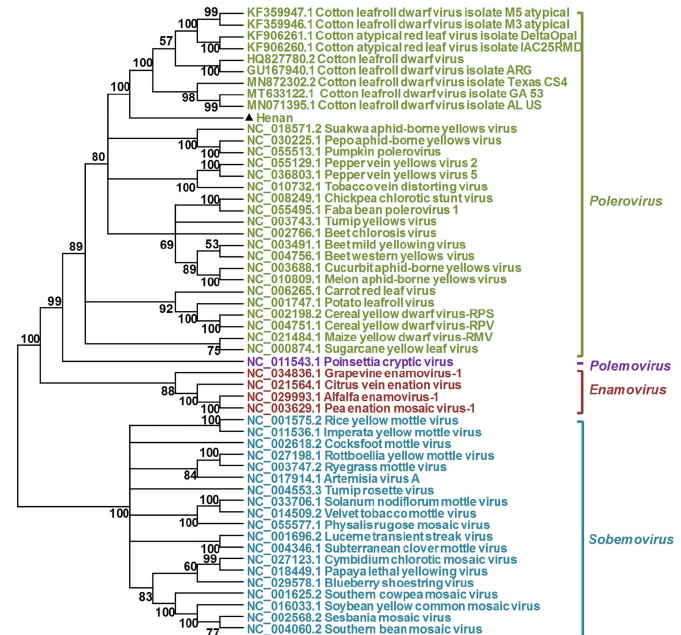
Figure 4. Phylogenetic analysis of cotton leaf roll virus and selected member viruses of the family Solemoviridae based on complete genome sequences. The accession number of each selected solemovirus is shown as indicated. The phylogenetic tree was constructed using the neighbor-joining method implemented with MEGA6, using a bootstrap replicates of 1000. Numbers shown next to the branches represent bootstrap values from 1000 replicates.